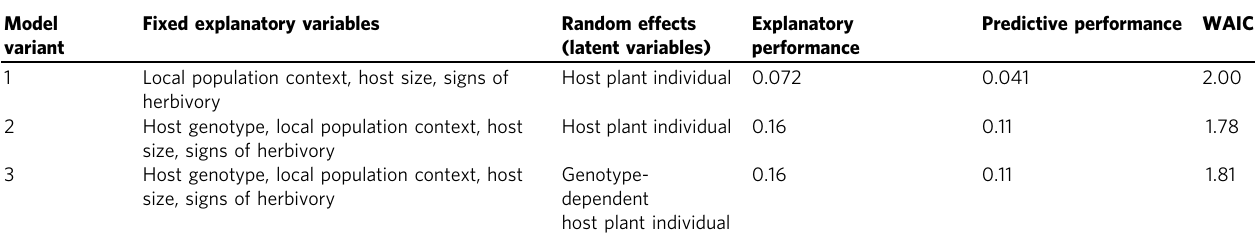
host plant genotype as a covariate, was clearly inferior. Model variant 2 also resulted in the smallest WAIC value, implying best predictive power. We did not detect any signi fi cant residual co- occurrence patterns between viruses after accounting for the effect of the local population context and host-related variables.